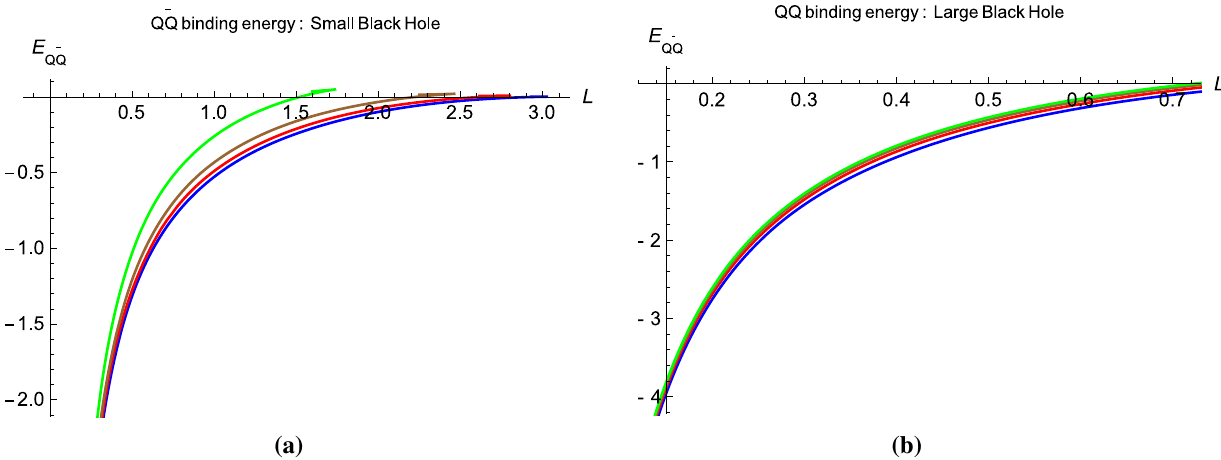
Fig. 11 Q ¯ Q binding energy for different ¯ a values, ¯ a = .4 (green), .3 (brown), .2 (red), .1 (blue) a small black hole, T = 1, b large black hole, T = 0 . 4;